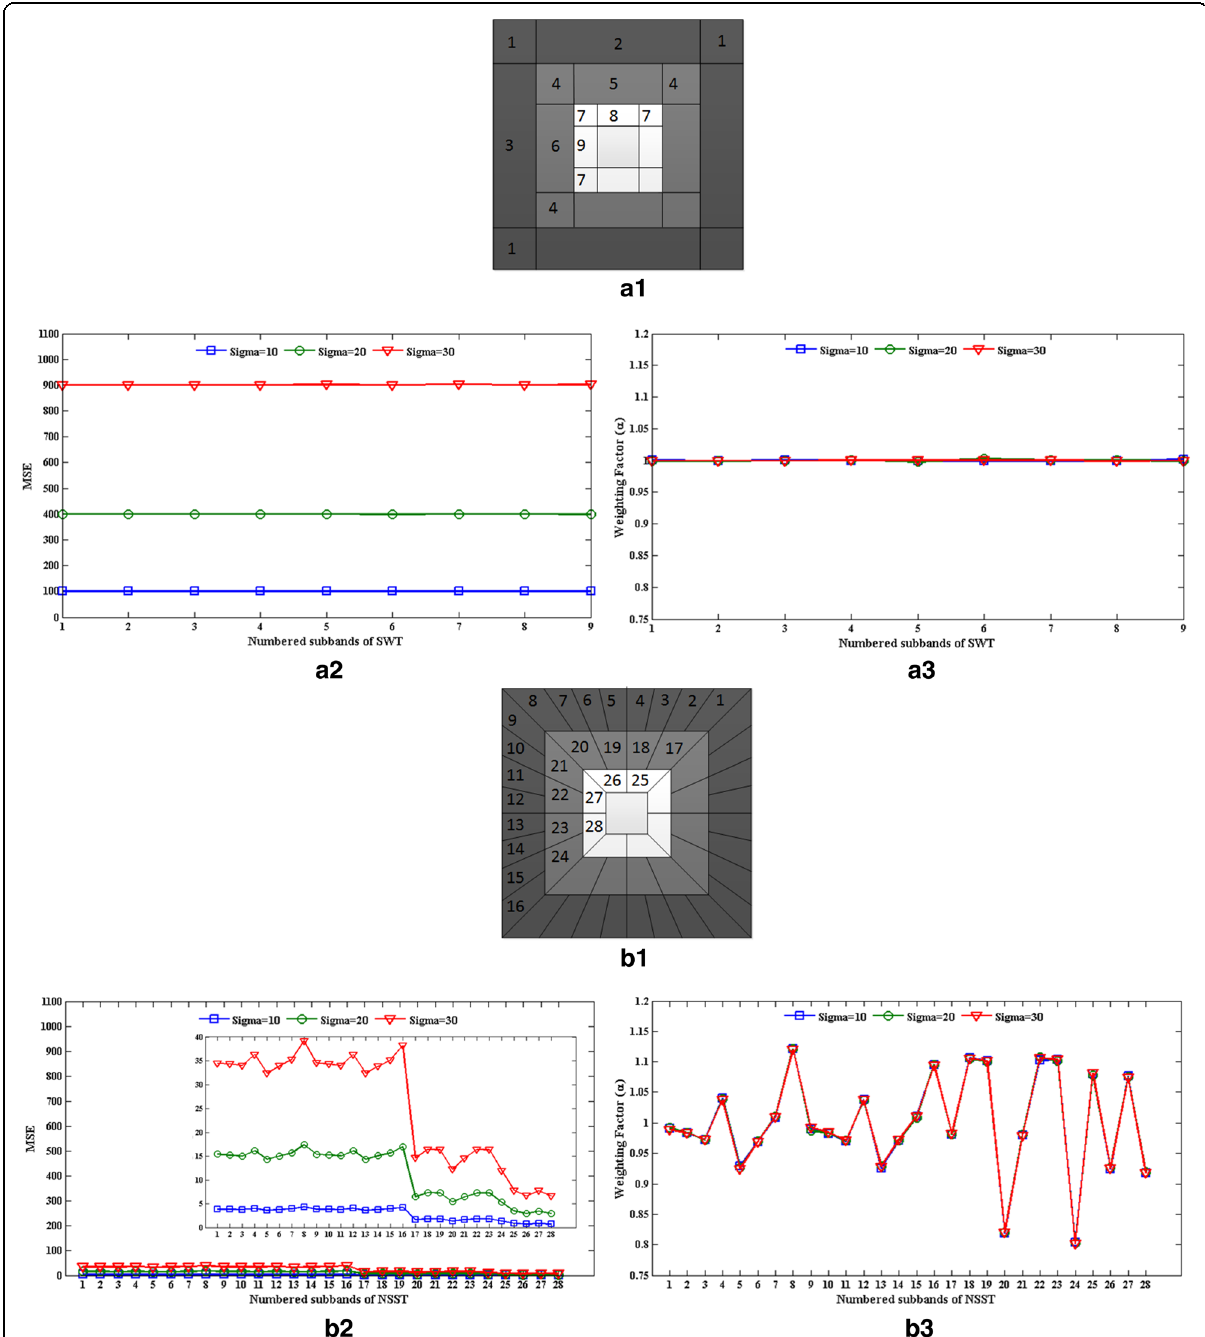
Fig. 5 ( a1 , b1 ) The numbered subbands, ( a2 , b2 ) average MSEs for three noise variances where eight test images were used, ( a3 , b3 ) the computed weighting factor for each decomposition level and every subband in SWT and